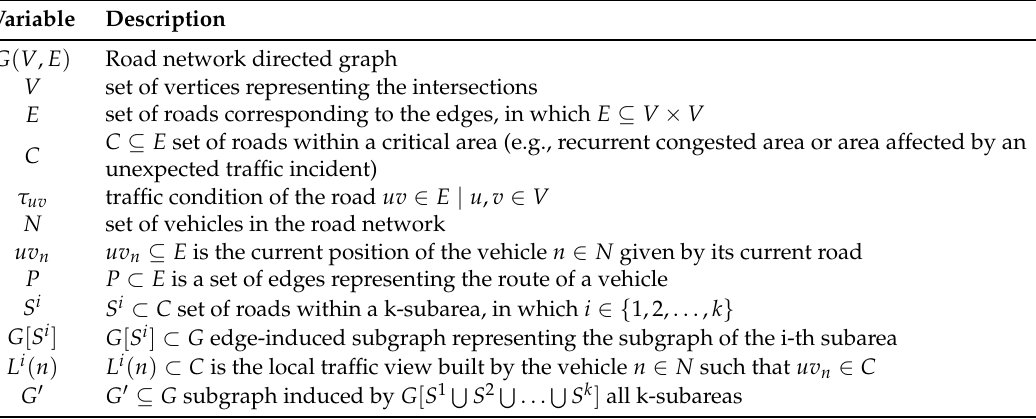
Table 2. Summary of definitions employed by I am not interested in it